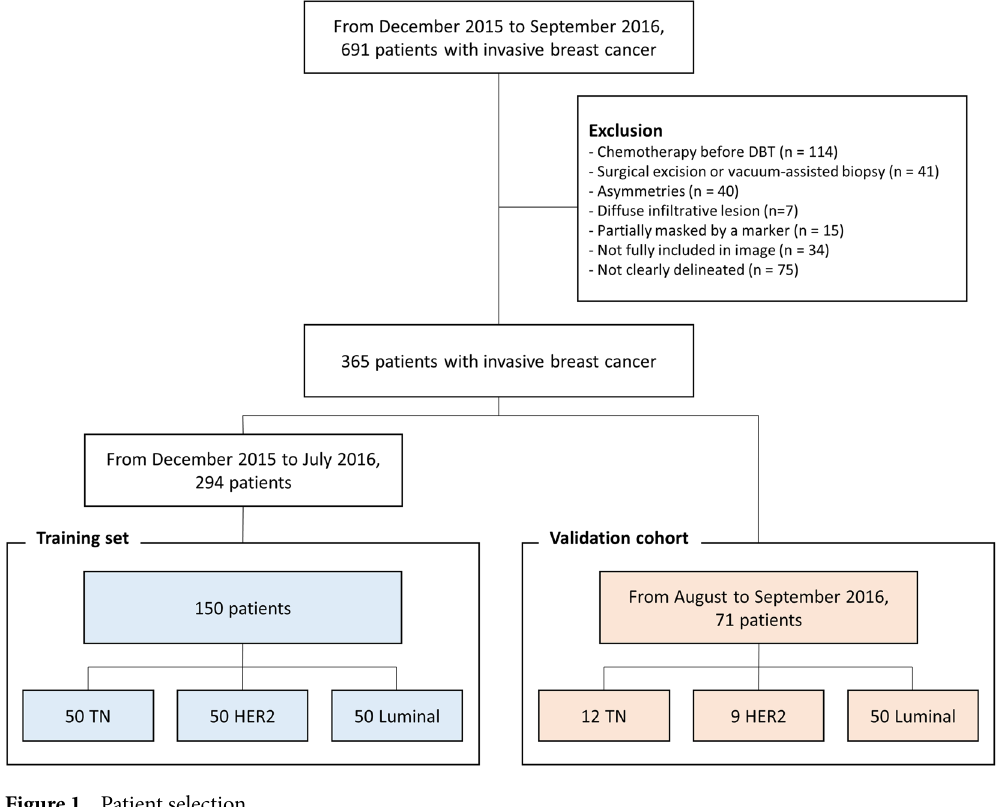
Figure 1. Patient selection.